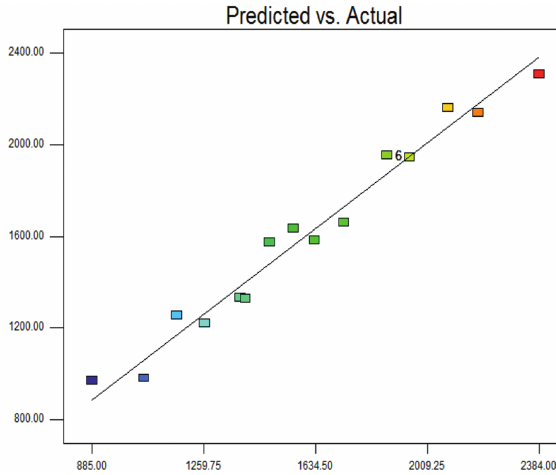
Figure 2: Predicted vs experimental iodine number of